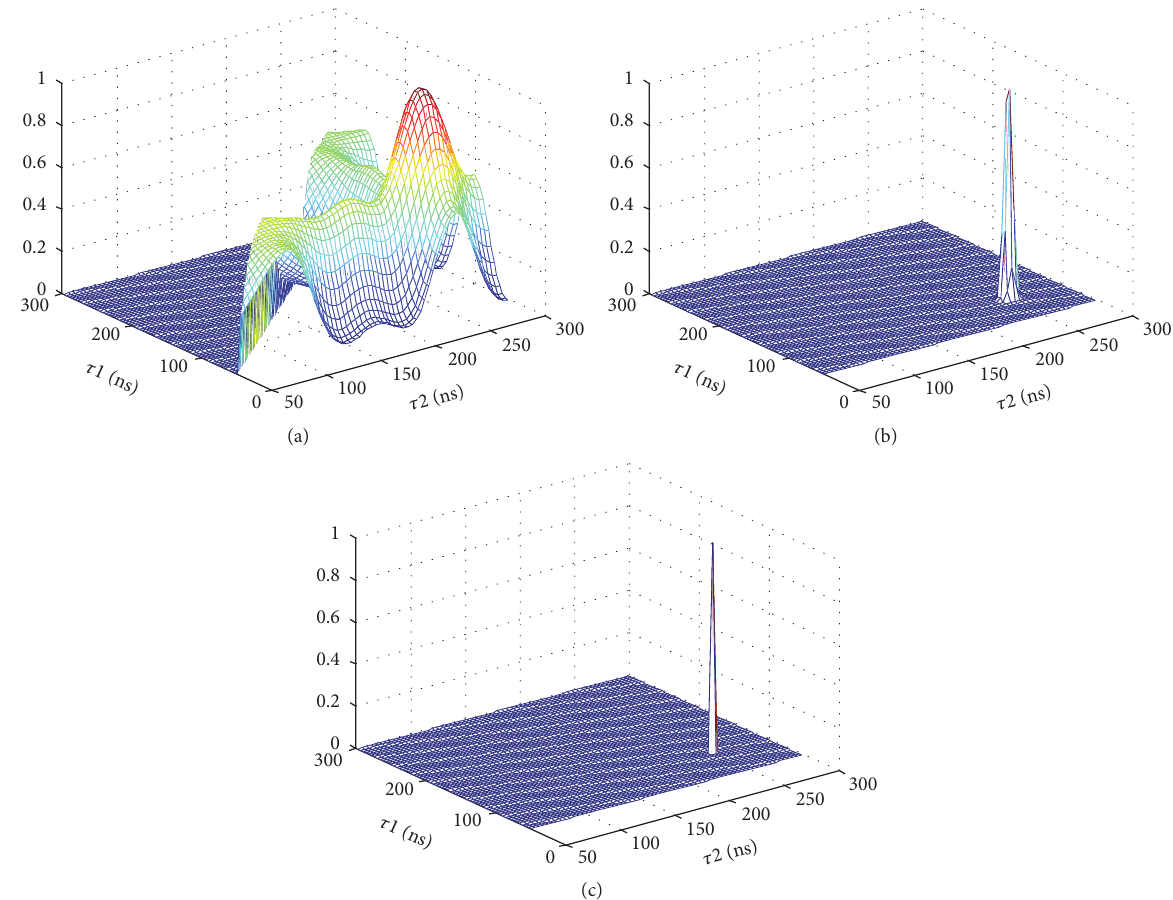
Figure 1: (a) Normalized likelihood function. (b) Normalized exponential likelihood function with 𝜀 0 = 1 . (c) Normalized exponential likelihood function with 𝜀 0 = 100 .